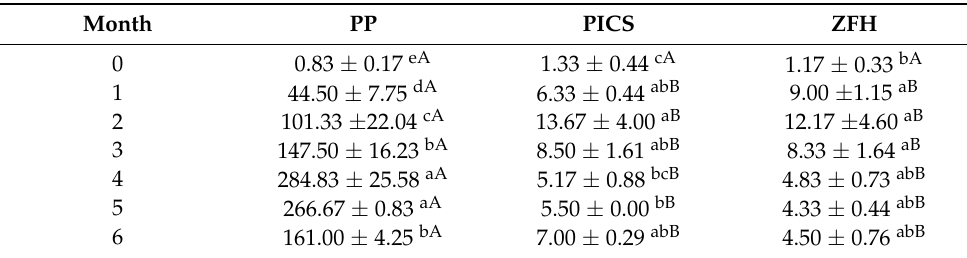
Table 2. Mean ( ± SE) number of insects in maize in Polypropylene (PP), Purdue Improved Crop Storage (PICS), and ZeroFly ® Hermetic (ZFH) bags sampled during the months of October 2020– March 2021.